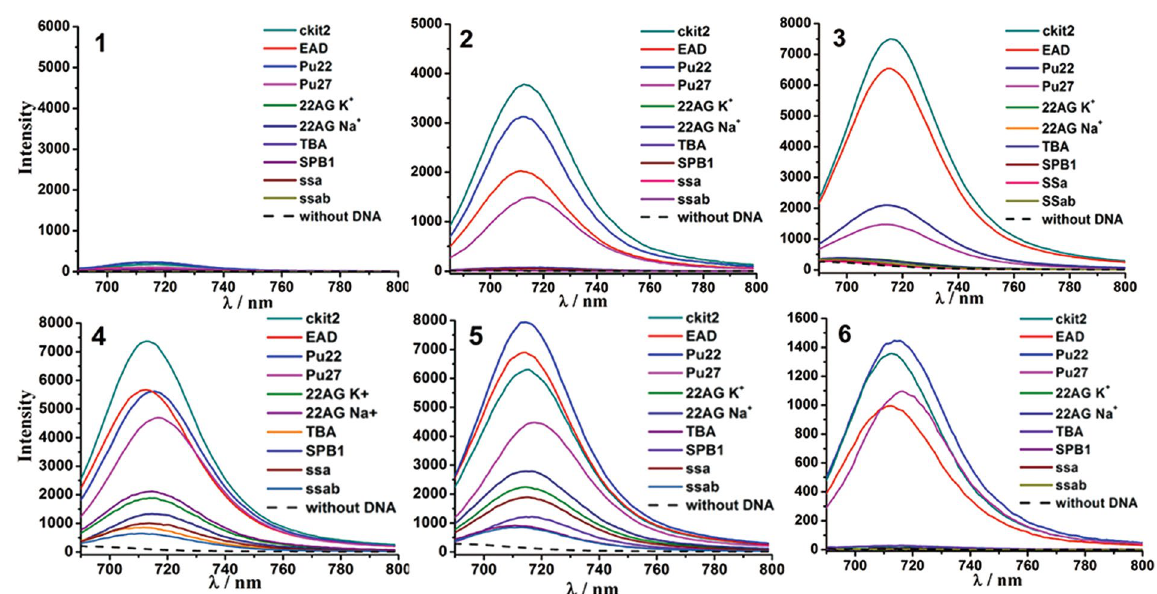
Figure 4. Fluorescence spectra of 1–6 (5 μ M) with different DNA sequences (15 μ M) in Tris-HCl